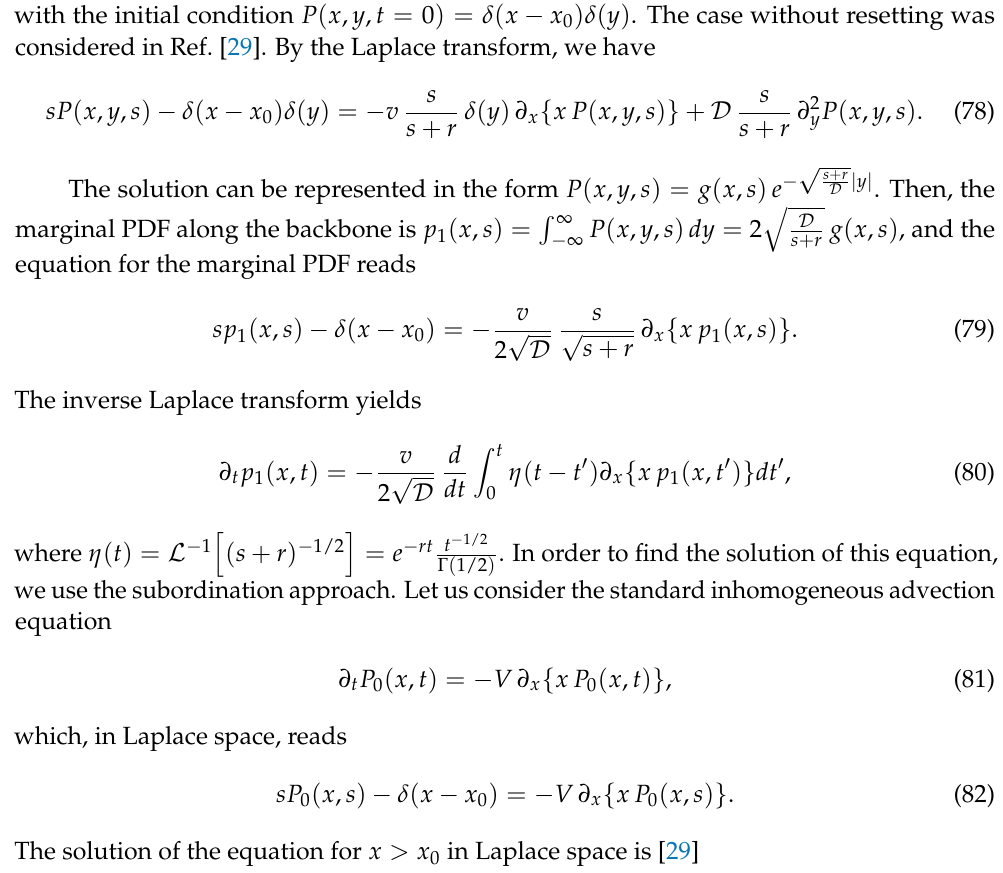
Figure 10. The survival probability for the random search with the drift on the comb for D x = 1, D y = 1, v = 0, and X − x = 2 (blue solid line), v = 1 and X − x 0 and X − x 0 = 2 (black dot-dashed line). The numerical results are represented by dots, triangles, and